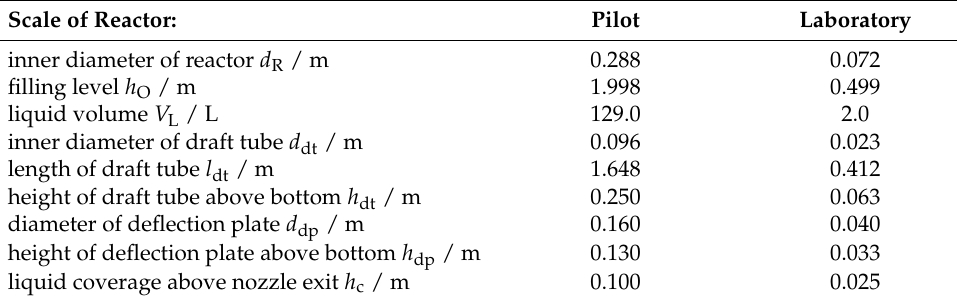
Figure 3. ( a ) Sketch of the scaled nozzle and gas capillary for the laboratory-scale reactor and ( b ) size of actual nozzle attachment manufactured in 1.4571 by Forschungswerkstatt Maschinenbau (FWM). Table 1. Important dimensions of the reactor